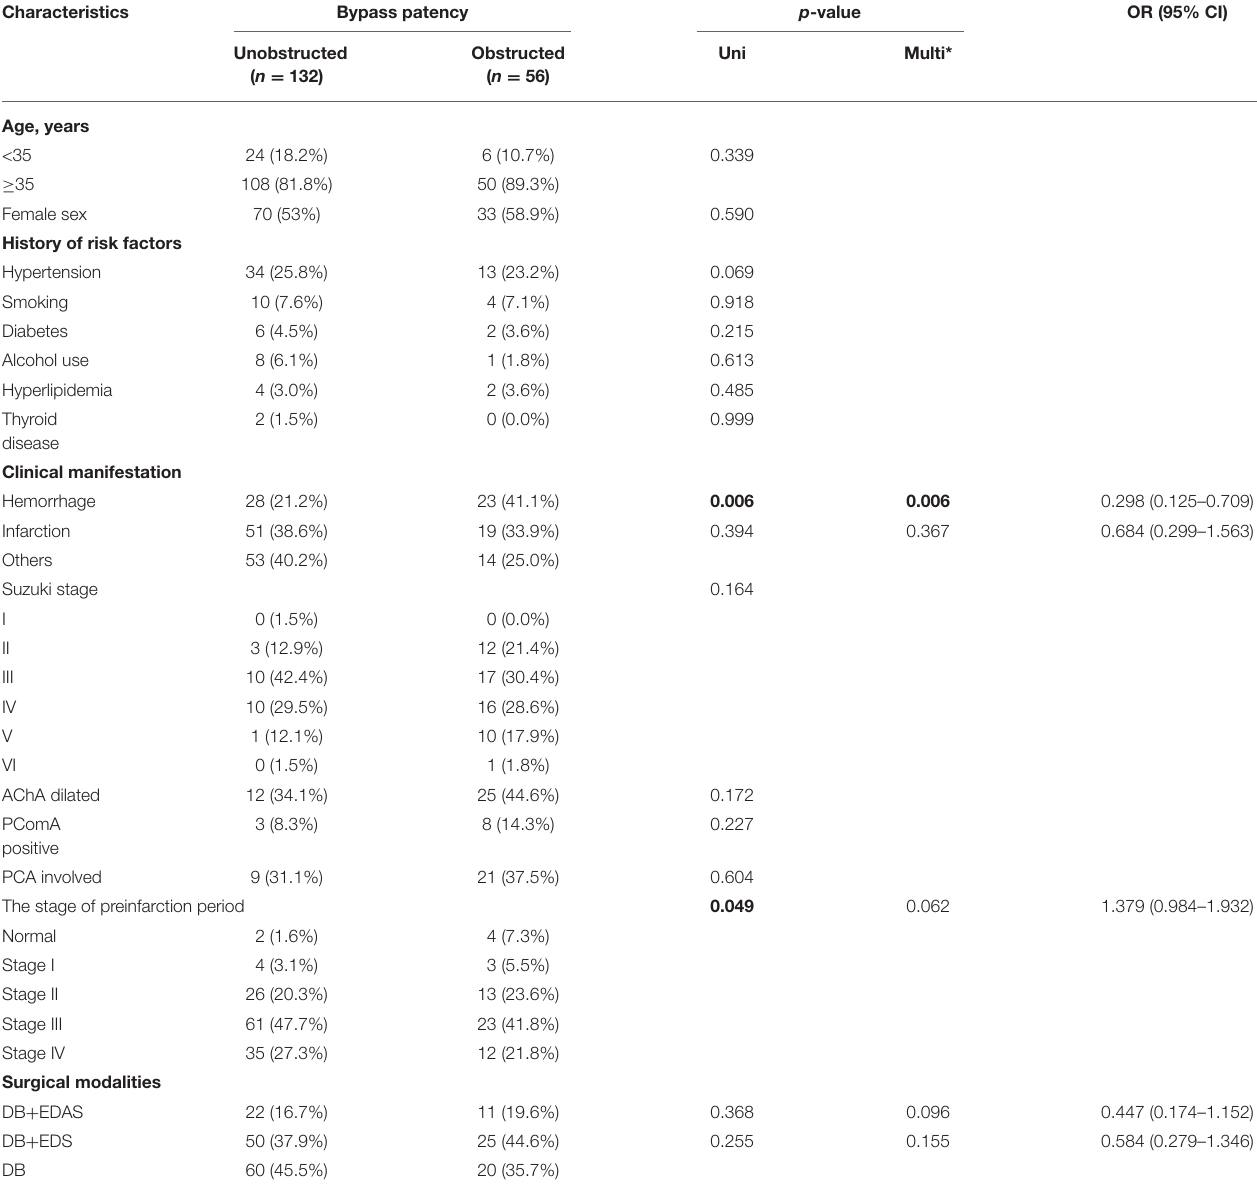
TABLE 3 | Logistic regression analysis of predictors for bypass patency.